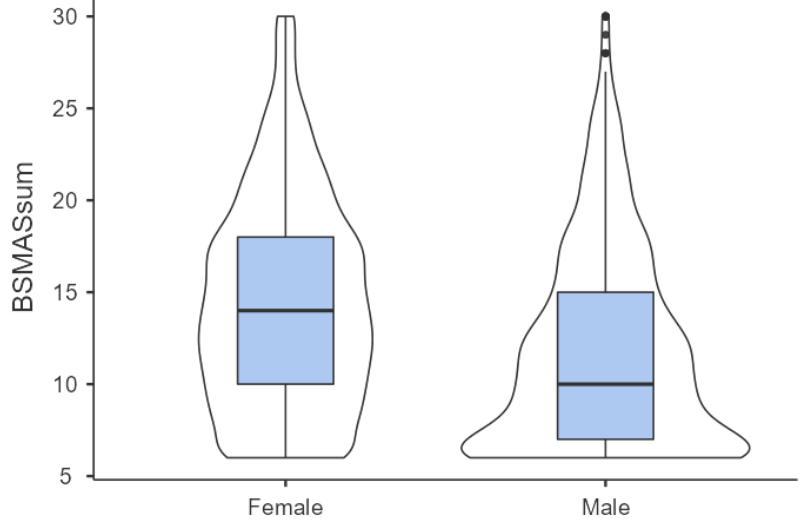
Figure 2. Distribution of total BSMAS scores for both genders.